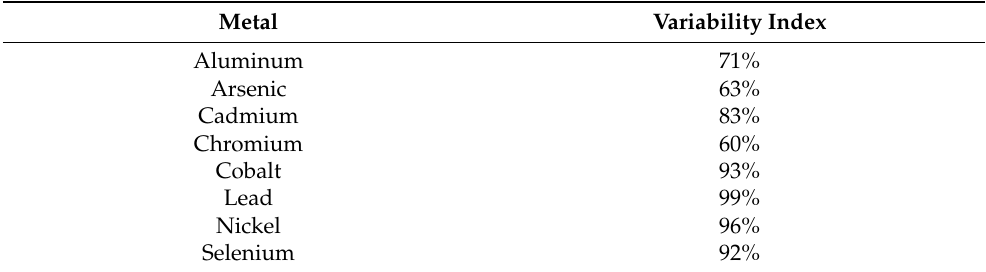
Table 1. The level of plasticity in Cycas micronesica seed gametophyte concentration among eight metals. Variability index was calculated with ((maximum − minimum)/maximum) ×